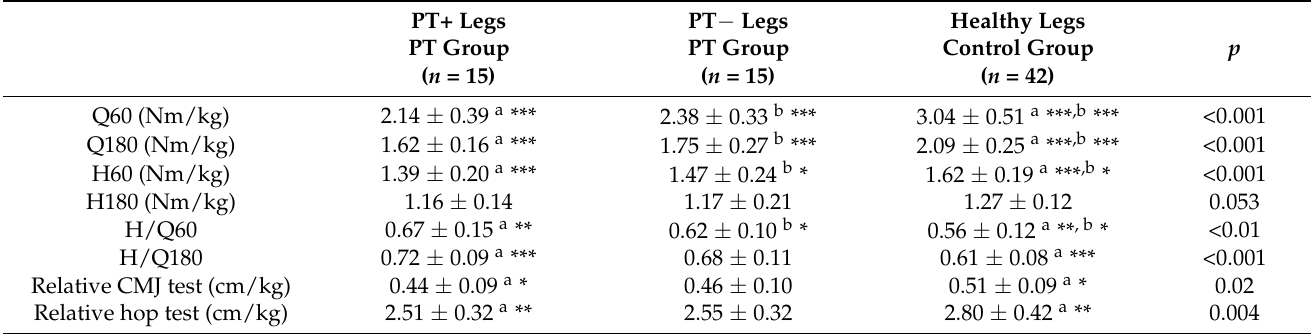
Table 3. Comparison between the affected legs with patellar tendinopathy (PT+ legs), the unaffected legs in patients with contralateral patellar tendinopathy (PT − legs) and the legs of control volleyball players (healthy legs) (Kruskal–Wallis test followed by Dunn post hoc